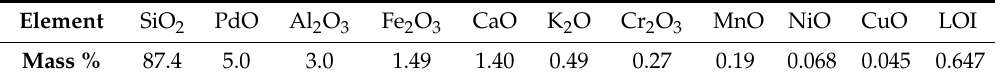
Table 5. Chemical composition of RHA.